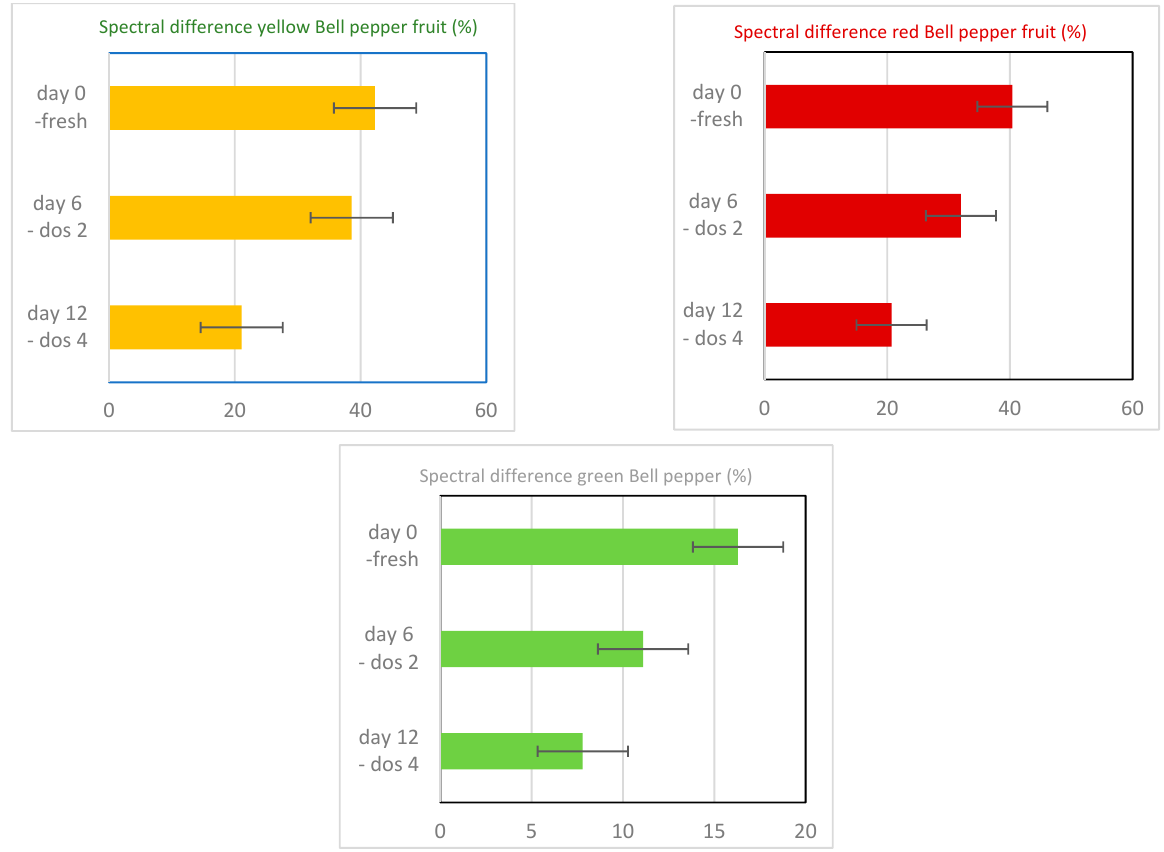
Table 4. Freshness index based on the difference between light reflection at 630 nm and